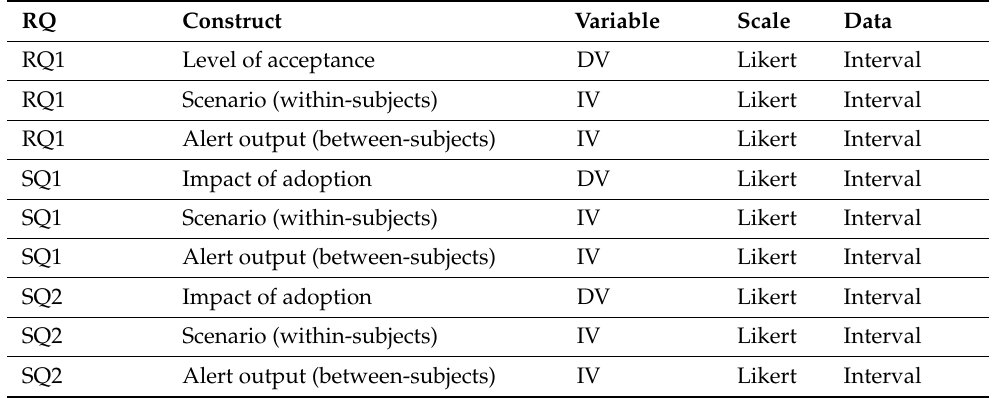
Table 1. Variable and data